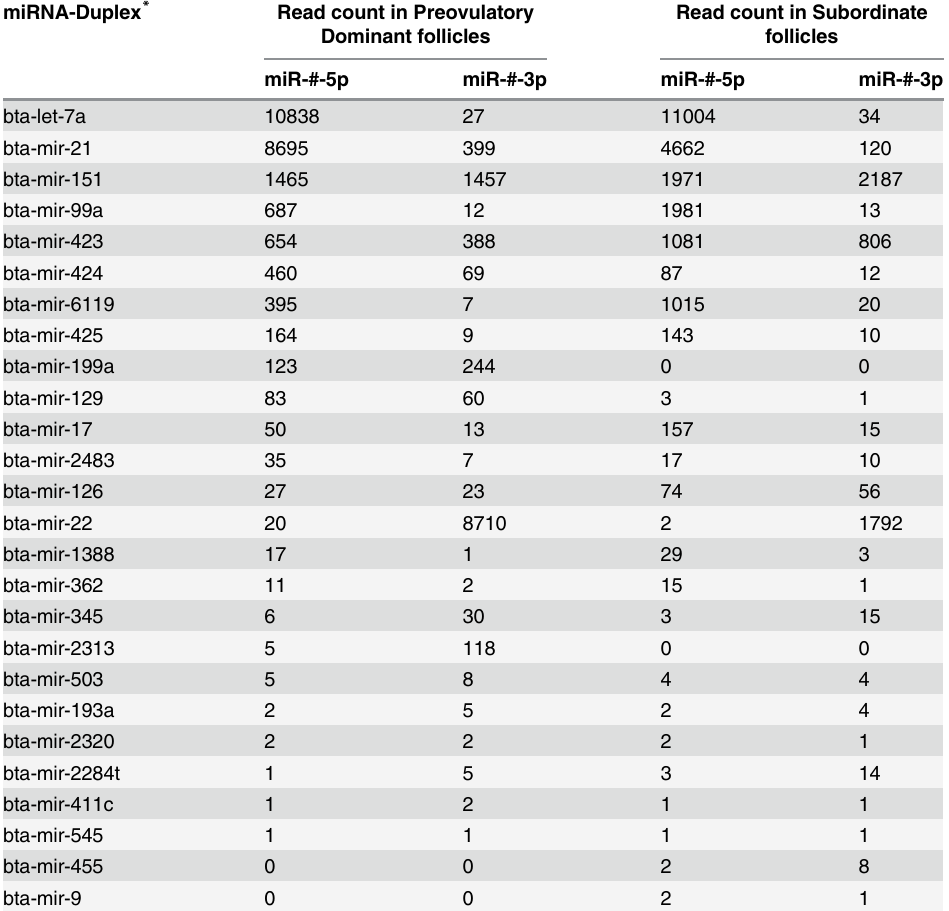
Table 3. Expression pattern of miRNA-duplexes in preovulatory dominant and subordinate follicle libraries. miRNA-Duplex * Read count in Preovulatory